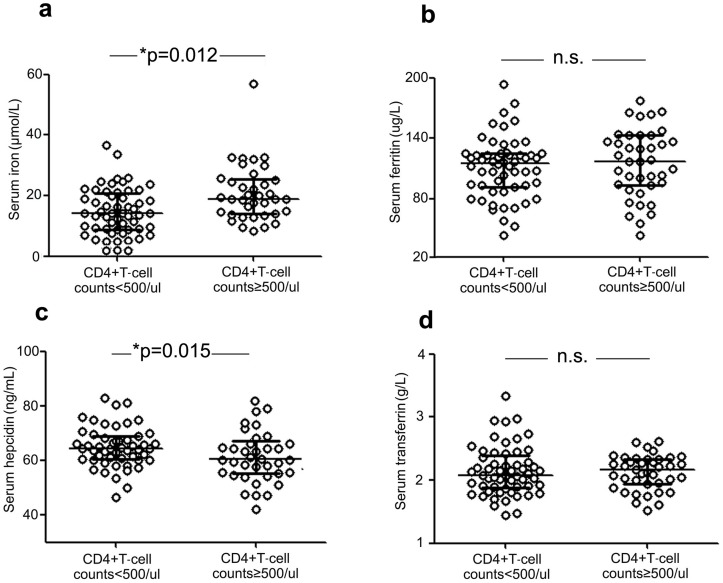
Comparison of iron-associated parameters in HCV/HIV-coinfected patients according to immune status.Serum concentrations of iron (a), ferritin (b), hepcidin (c), and transferrin (d) were measured in HCV/HIV-coinfected patients and then compared with CD4+T-cell counts (<500/µl vs. ≥500/µl). Data are expressed as the median and inter-quartile range. Differences between two groups were determined using Student's t test and a two-sided P<0.05 was considered statistically significant. (Asterisks indicate P values <0.05.).